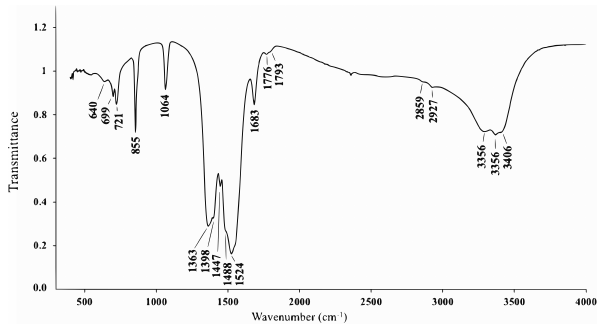
Figure 4. Infrared spectrum of alicewilsonite-(YCe). Figure 5. General view of the crystal structure of alicewilsonite-